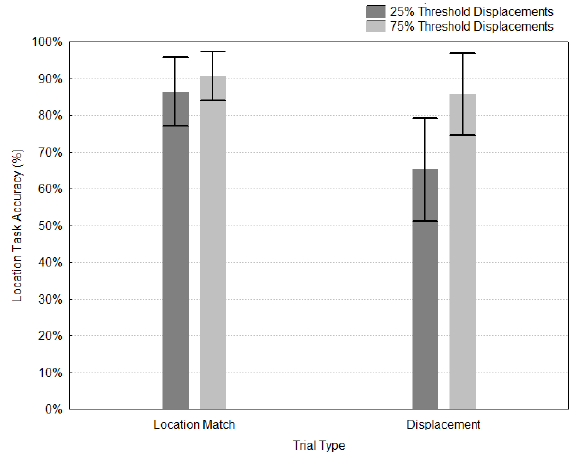
Figure 2. Location task accuracy as a function of trial type (cue-probe location match versus probe displacement) and block type (25% vs 75% displacement thresholds). Black bars indicate one standard error of the